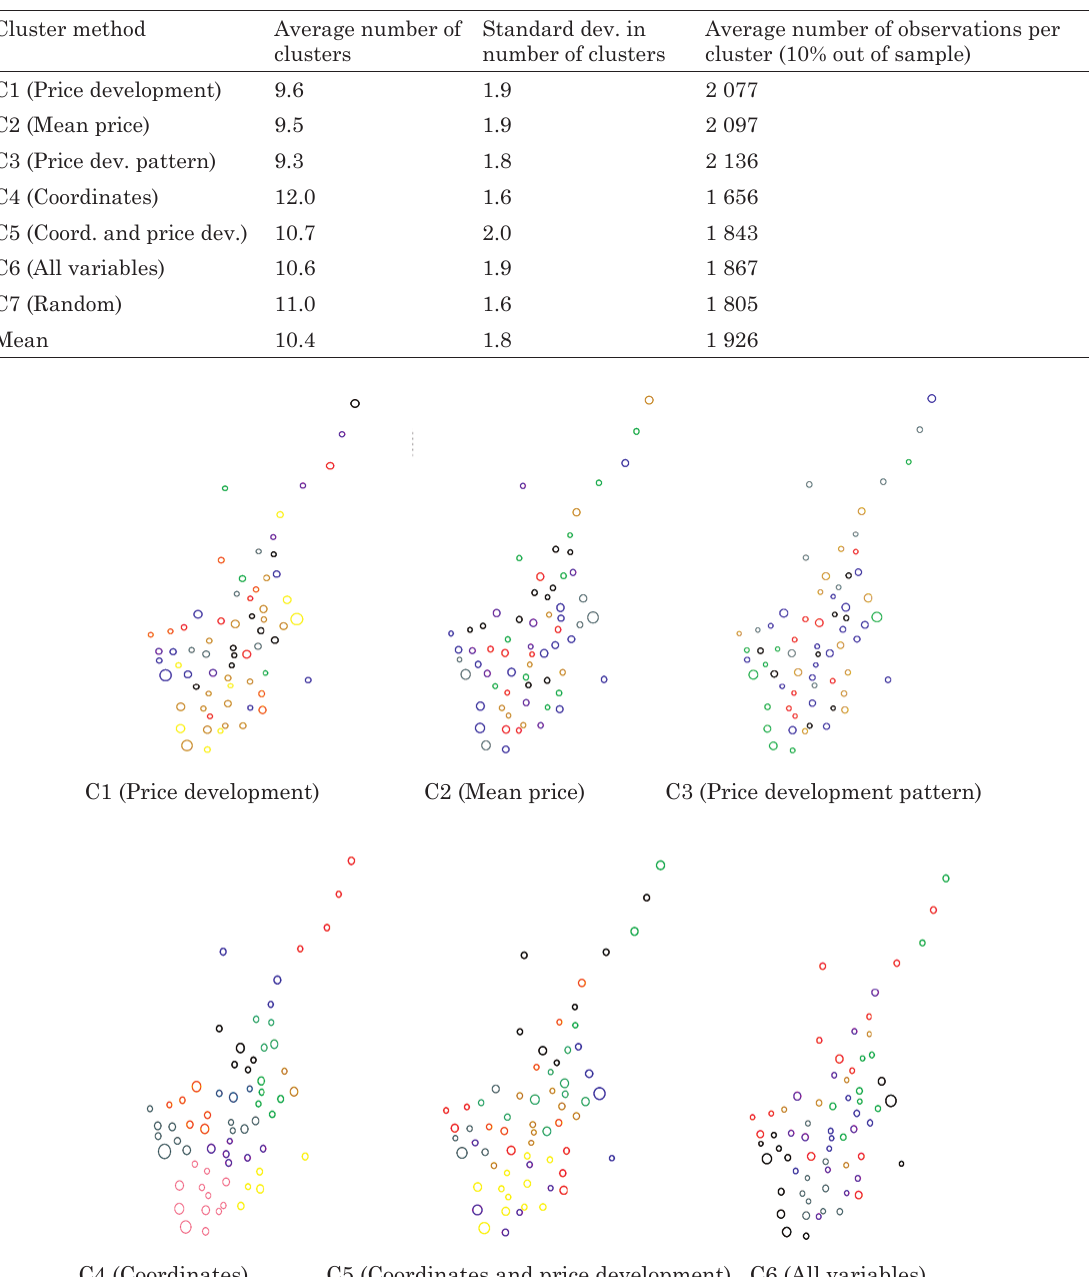
Table 4. Results of cluster analysis, methods C1-C6 Cluster method